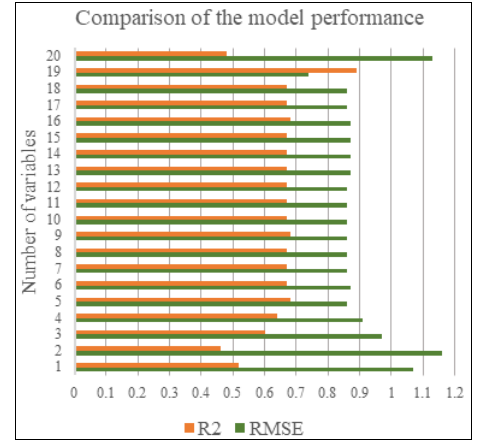
Figure 8 . Comparison of the model performance based on the variables’ importance